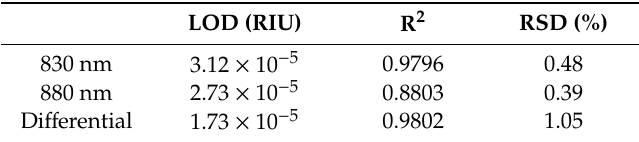
Table 2. The limit-of-detection (LOD), R 2 , and relative standard deviations (RSD) for 830 nm, 880 nm, and di ff erential value obtained by the refractive index